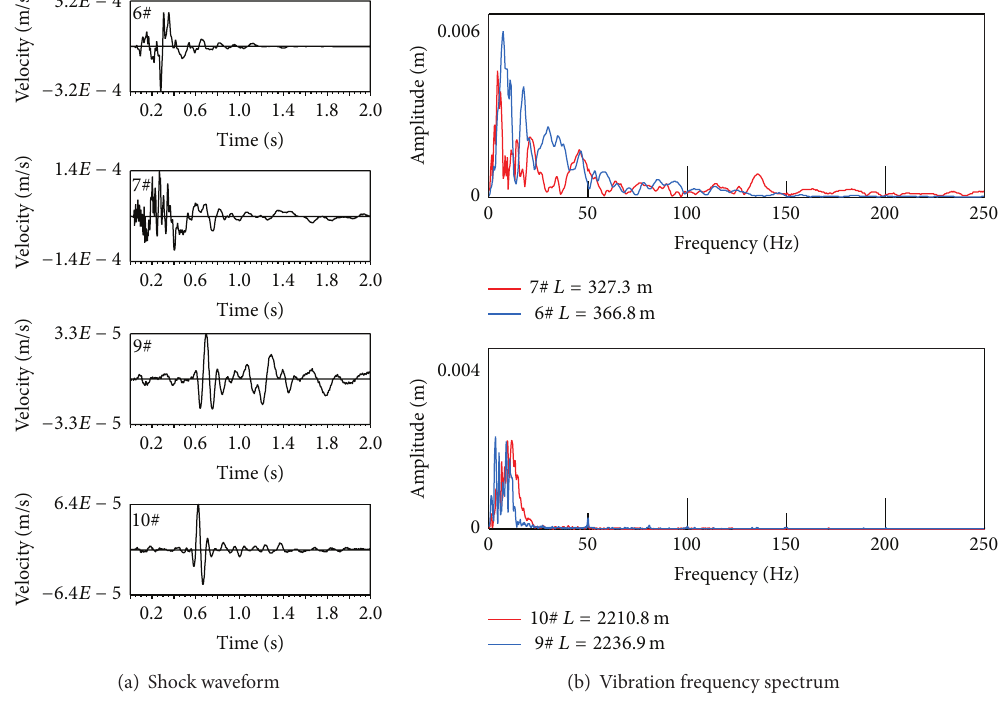
Figure 8: Range of particle vibration